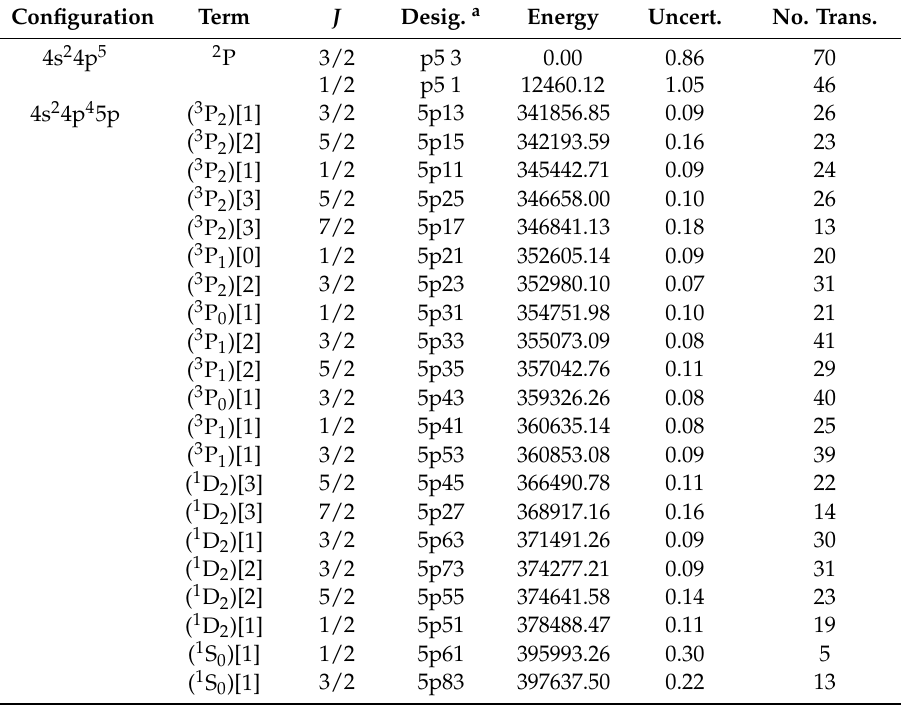
Table 2. Odd parity levels (cm − 1 ) of Y